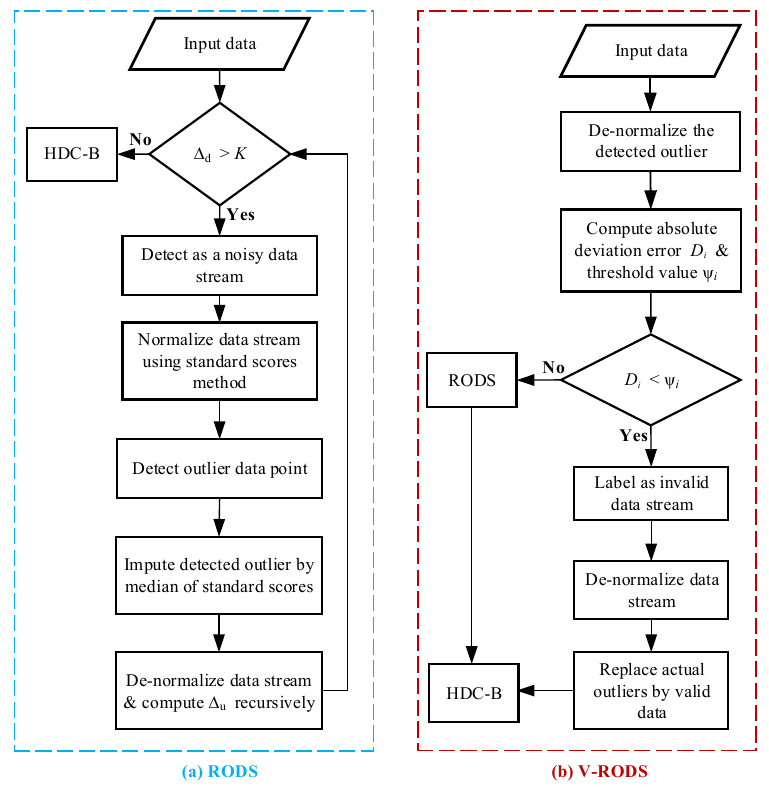
Figure 6. Execution flowcharts of the two modules of the EDC technique. ( a ) RODS with HDC; ( b ) V-RODS with